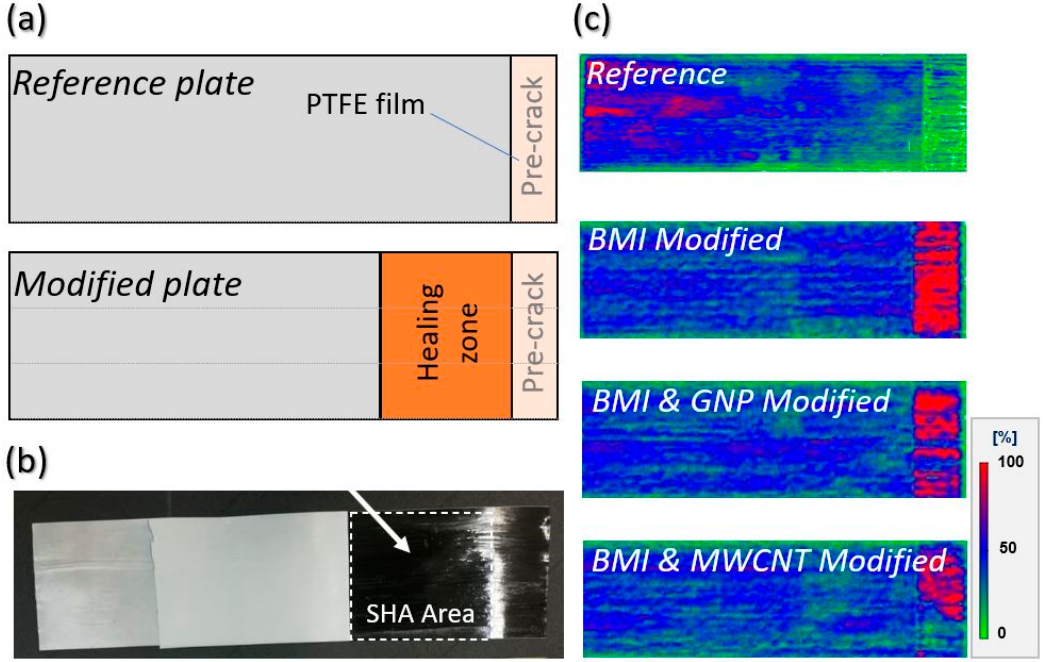
Figure 1. ( a ) Design of the reference and of the modified plates. ( b ) Illustration of a surface-modified pre-preg tape by electrospun SHA (BMI and TF). ( c ) C-scan inspection photographs of all material sets (reference and modified ones).